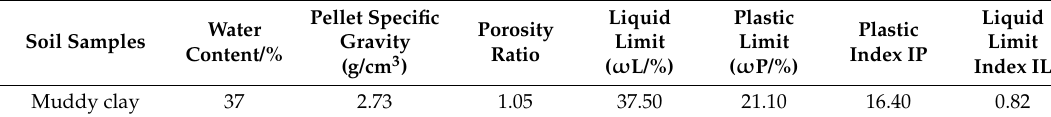
Table 3. Physical parameters of the soil sample.